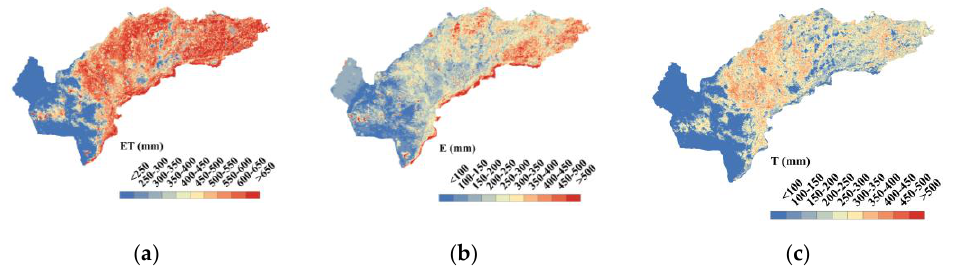
Figure 3. Spatial distributions of HTEM estimated total ET( a ), E( b ), and T( c ) during the growing season (April to October) in 2012.